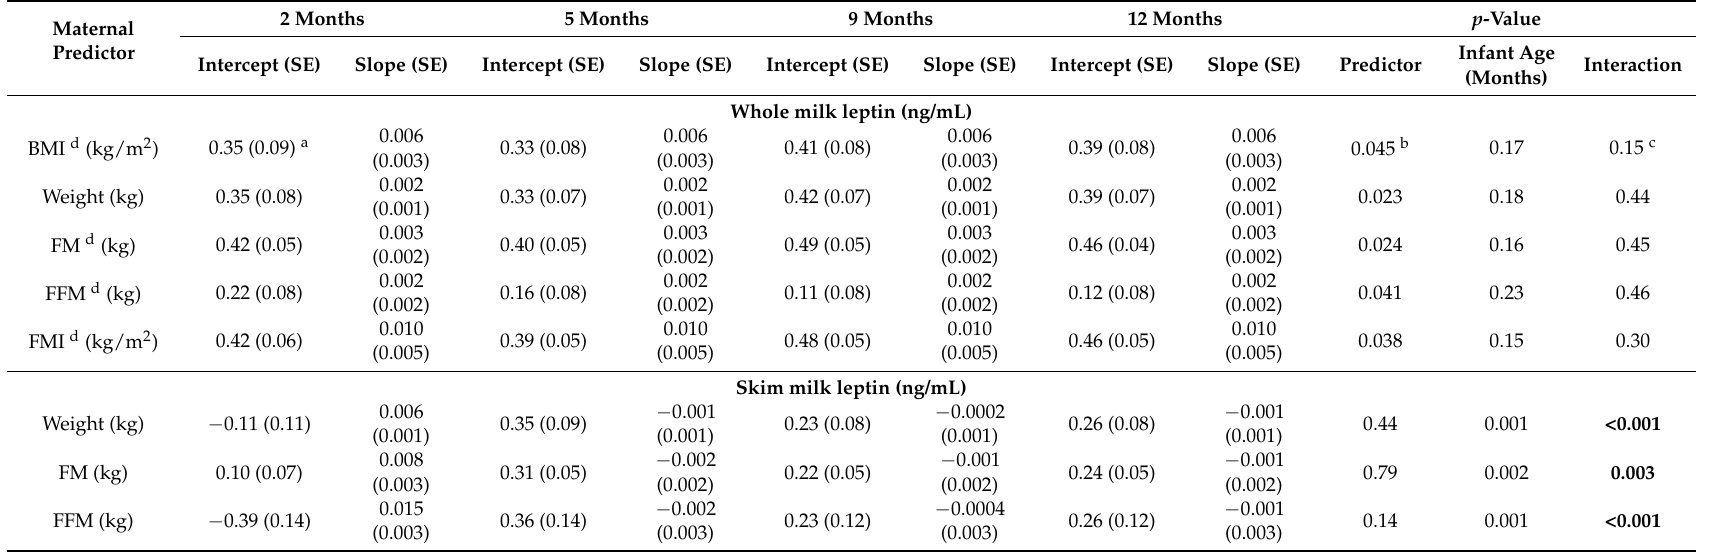
Table A1. Associations between maternal characteristics and concentrations of human milk